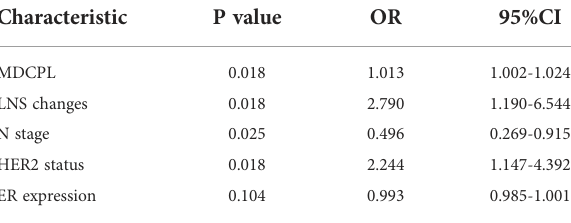
TABLE 4 Results of variables associated with apCR in multivariable logistic regression analysis. Characteristic